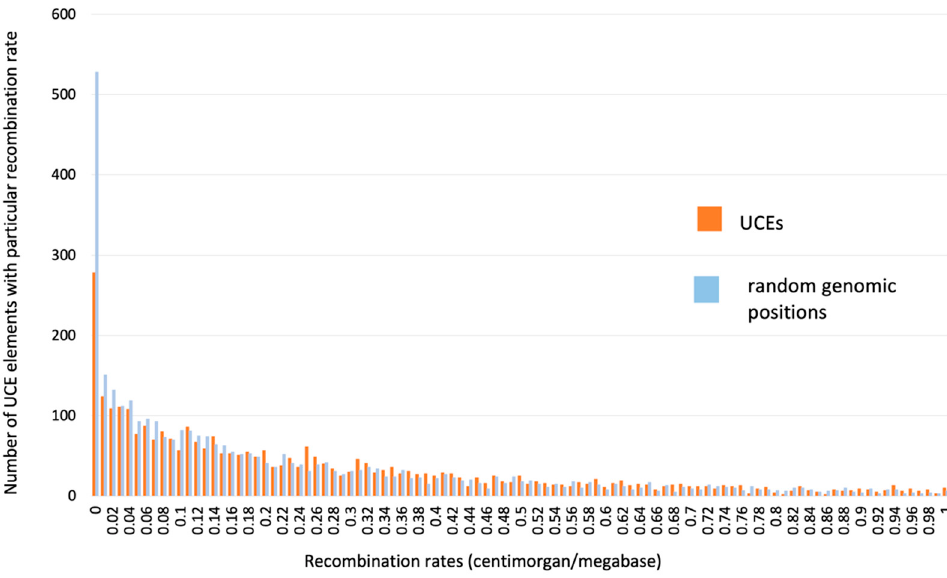
Figure 3. Distribution of meiotic recombination rates inside UCNEs versus random genomic positions (so-called “random-UCNEs”). Recombination rates were divided into equal-sized intervals of 0.02 centimorgans (cM) per one million nucleotides, which are shown along the horizontal axis. The number of UCNE and “random-UCNE” sequences that have a recombination rate within a particular interval (bin) are plotted along the vertical axis. Table 4. Genomic signatures ( ρ ) of the UCNE sequences versus the whole genome. Note that complementary dinucleotides (e.g., TG and CA) have the same genomic signatures. Green color highlights the overabundant dinucleotide GpC, while the red color the underabundant CC and GG dinucleotides. Standard errors are shown for ρ (UCNEs). Different human chromosomes have slightly different nucleotide compositions, as shown in the Supplementary File NTcomposition.tar.gz. Therefore, their genomic signatures vary from chromosome to chromosome with fluctuations of about